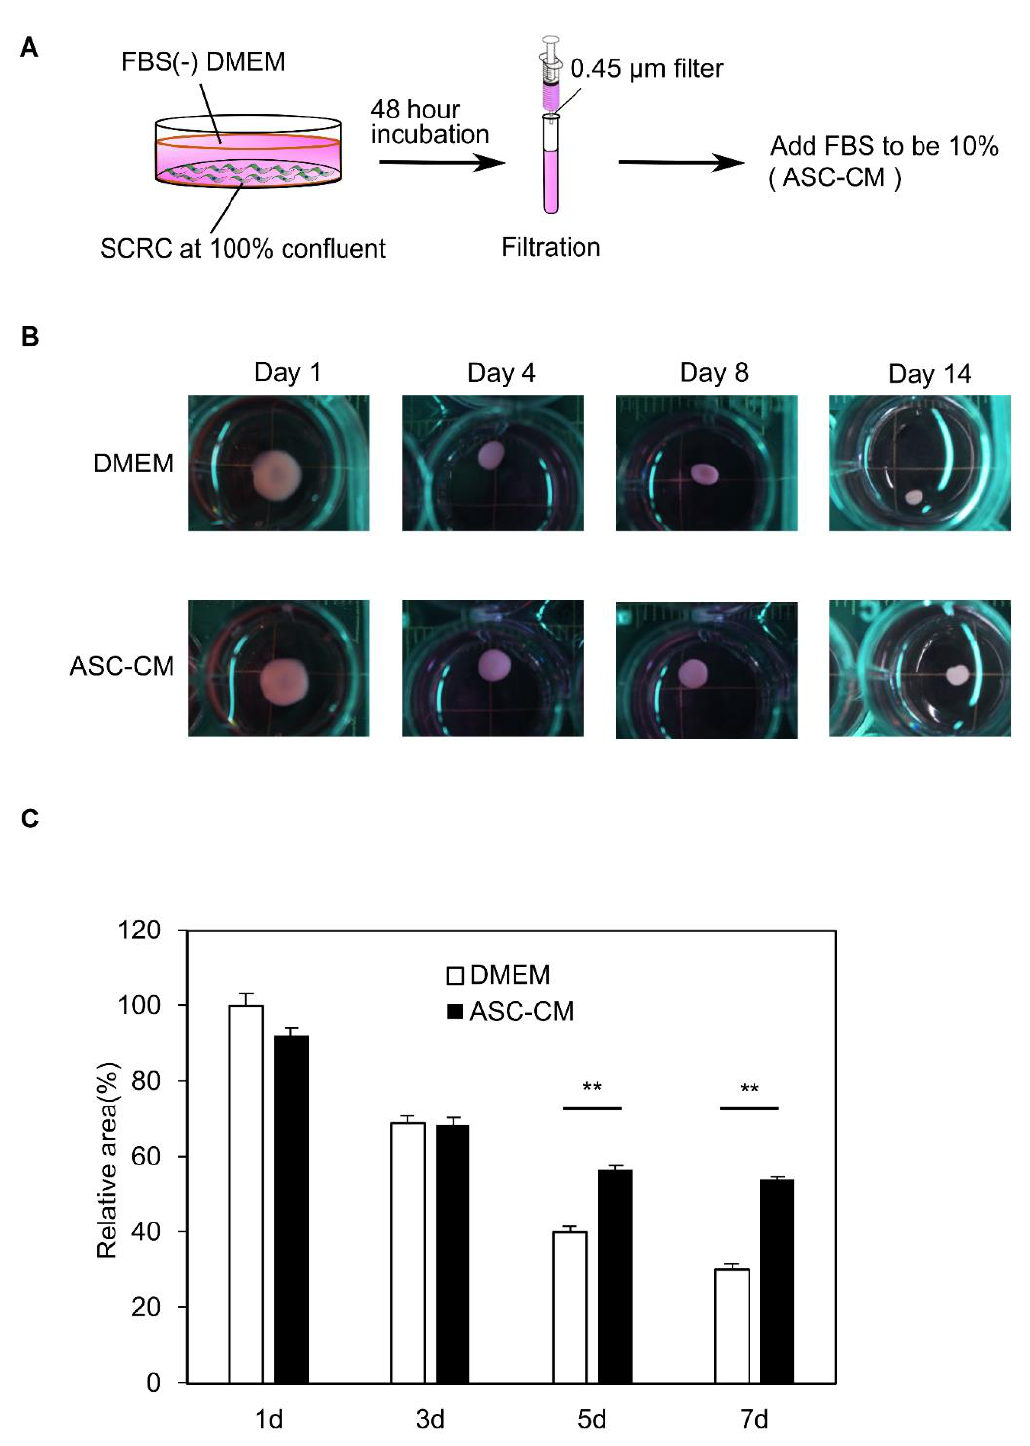
Figure 4. Suppression of shrinkage of KF disc by ASC-CM. ( A ) Schematic representation of ASC-CM preparation. ( B ) Images showed the difference in shrinkage of KF disc treated with DMEM or ASC-CM. ( C ) The relative contraction area was calculated as a percentage of the day 1 DMEM group. Results are presented as the mean ± standard deviation of six biological replicates. ** p < 0.01, unpaired Student’s t -test. Abbreviations: ASC-CM, conditioned media derived from adipose stem cells; KF, keloid fibroblasts; DMEM, Dulbecco’s modified Eagle’s medium; FBS, fetal bovine serum.